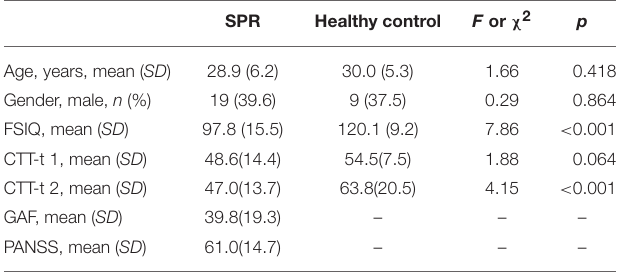
TABLE 1 | Demographic information on the schizophrenia (SPR) patients and healthy control